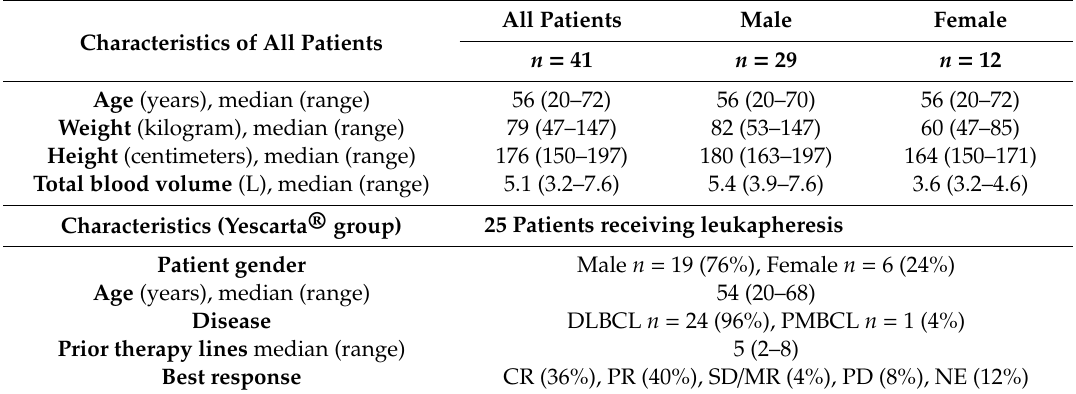
Table 2. Baseline characteristics of